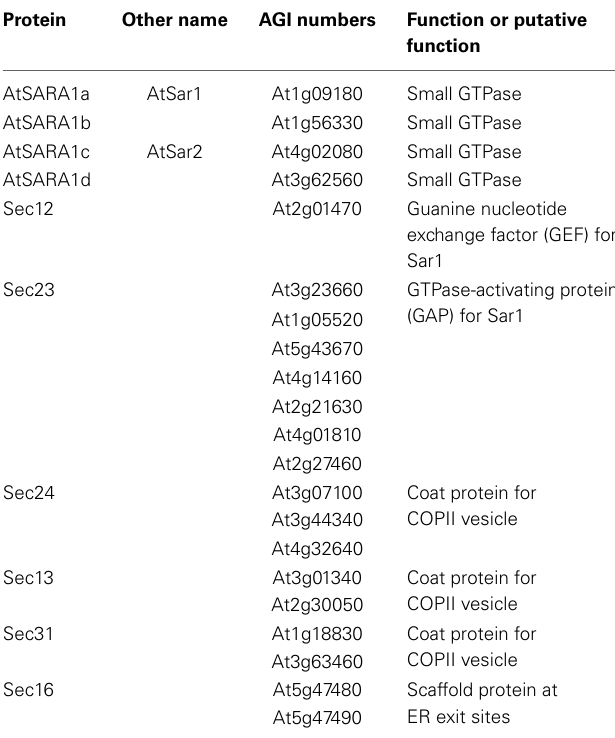
Table 1 | Arabidopsis Sar1 proteins and their interacting proteins.